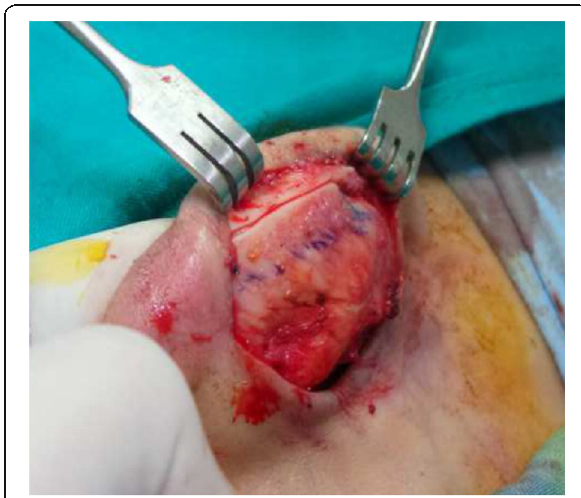
Fig. 4 The site for the creation of the antihelical fold is marked with methylene blue, and the cartilage is separated from the helical cartilage